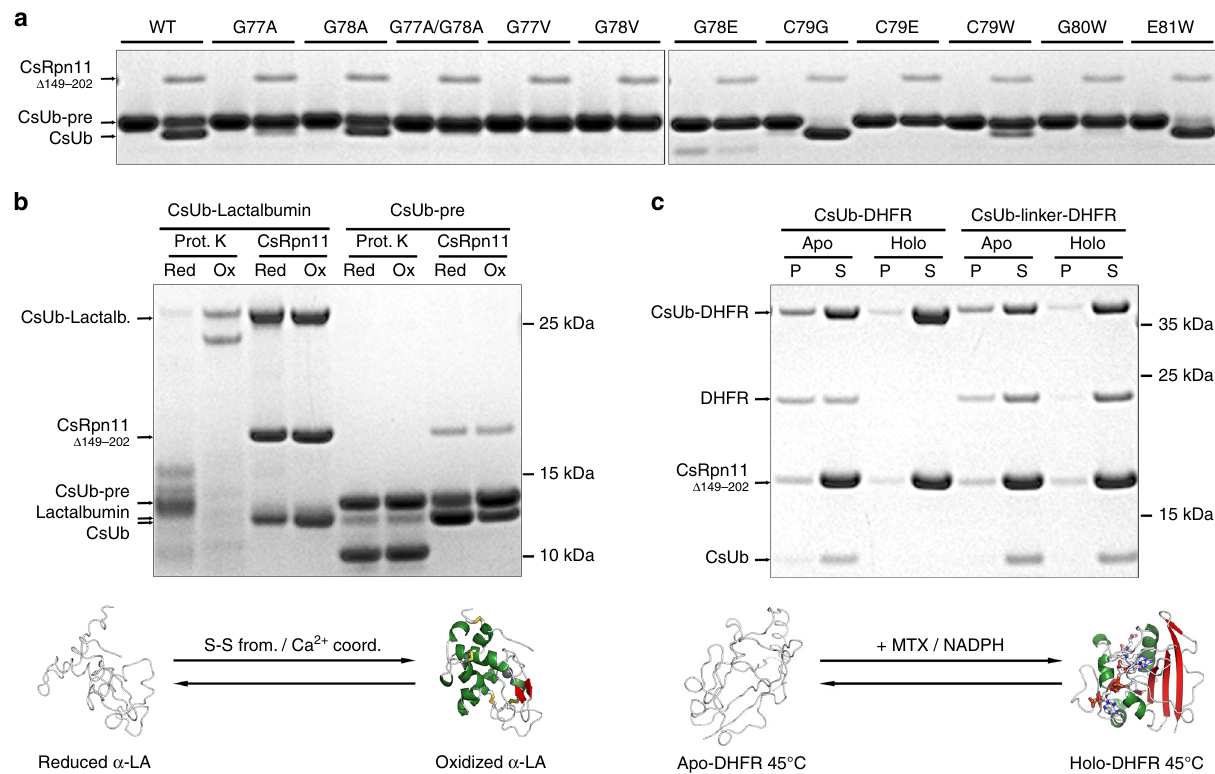
Fig. 7 Effects of CsUb-pre cleavage site mutations and the conformation of conjugated substrate on processing by CsRpn11. a Protein gels showing CsUb- pre mutants, each before and after CsRpn11 Δ 149 – 202 treatment. b Processing of a CsUb – Lactalbumin ( α -LA) fusion by CsRpn11 Δ 149 – 202 and proteinase K under reducing and oxidizing conditions. These conditions have only minor effects on the general activity of both proteases, as shown by the control digest with CsUb-pre alone. c Processing of a CsUb – DHFR fusion by CsRpn11 Δ 149 – 202 in the presence (Holo) or absence (Apo) of the stabilizing DHFR interactors MTX and NADPH 43 . At the assay temperature, Apo-DHFR unfolds and is found partially in the pellet (P), while Holo-DHFR is detected only in the supernatant